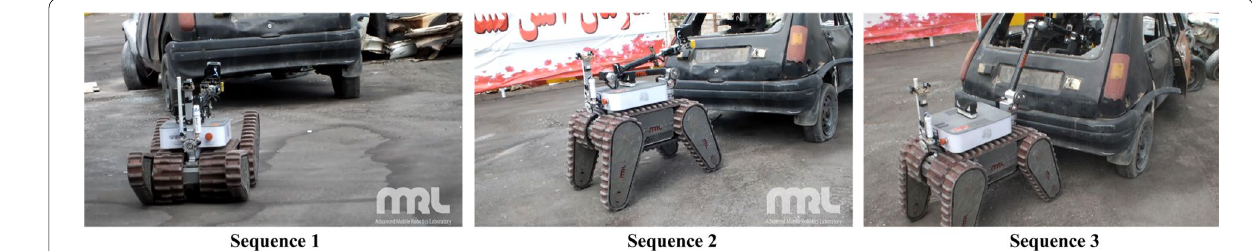
Fig. 28 The robot is performing a car inspection